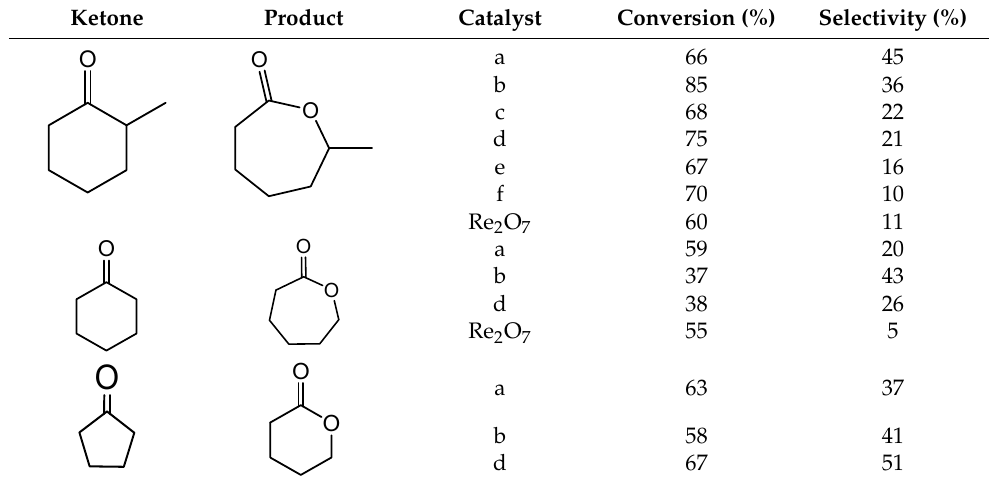
Figure 2. Structure of the PtII water-soluble catalysts [31]. Table 1. Catalytic performance of Re complexes for the oxidation of cyclic ketones to lactones. Ketone